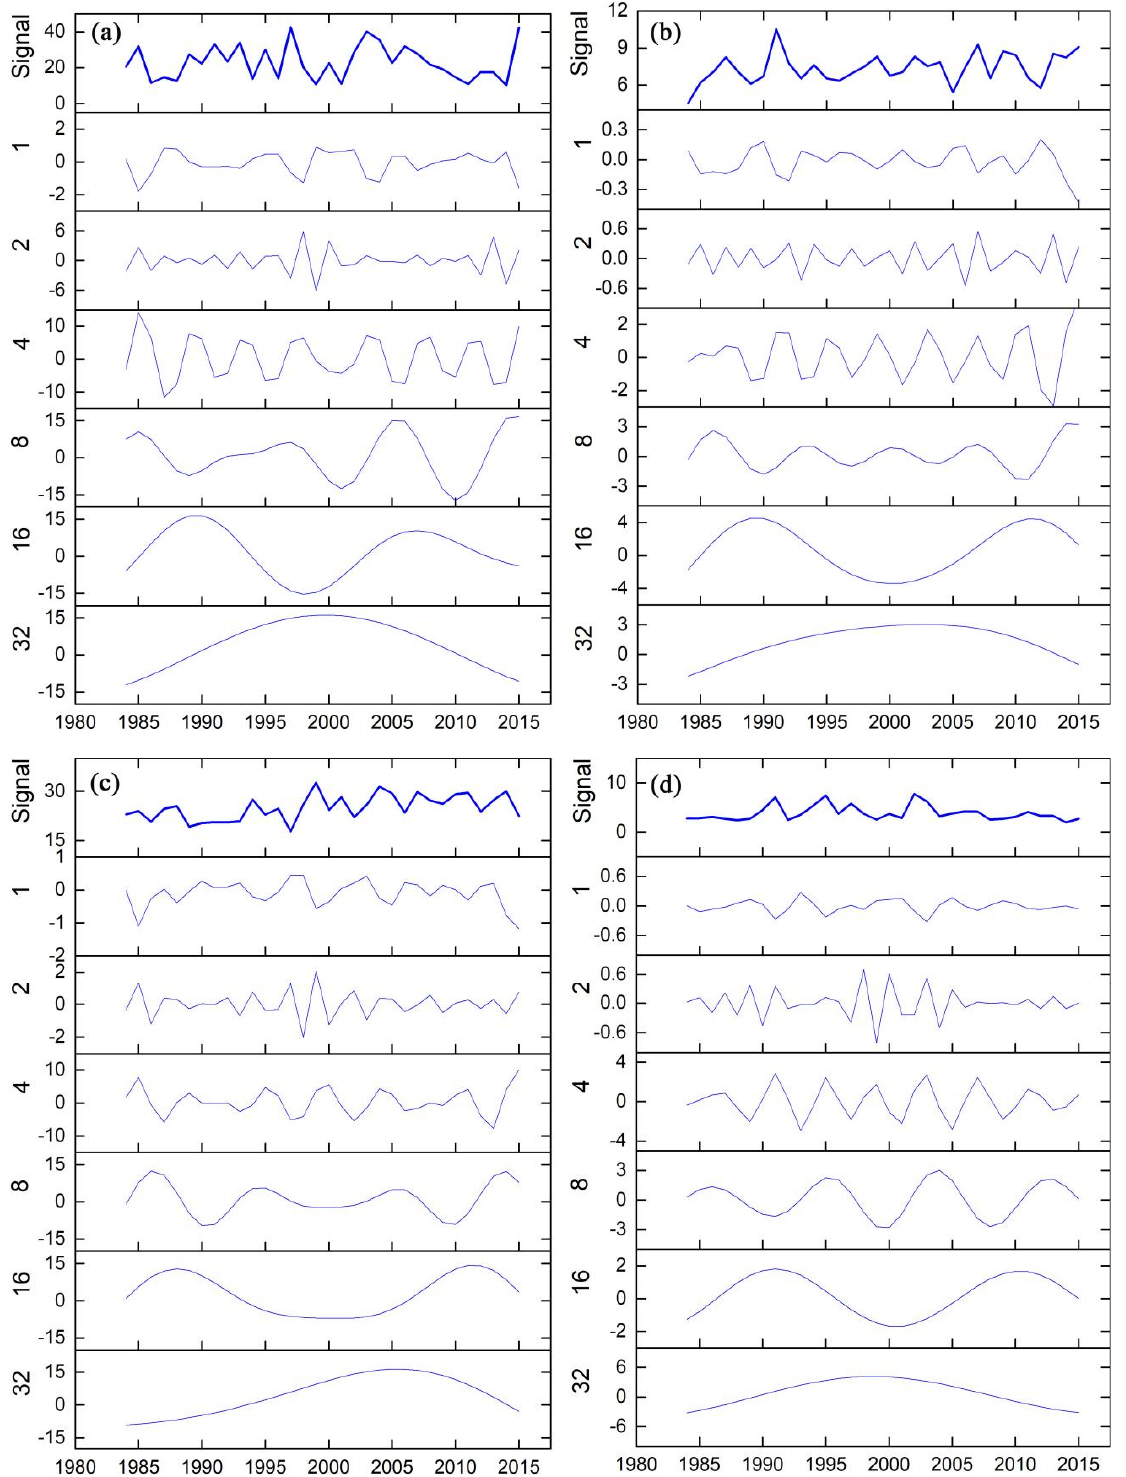
Figure 7. Multi-time-scale variations of rainfall ( a ), temperature ( b ), evaporation ( c ) and runoff ( d ) in winter. ( d ) in